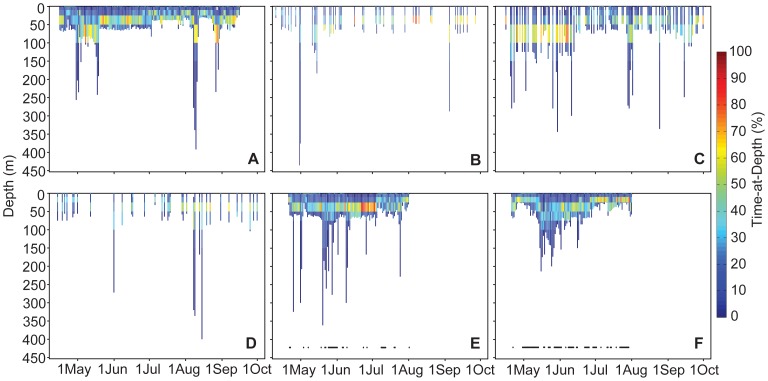
Percent daily time at depth.Daily time-at-depth (indicated by color across y-axis) by Manta alfredi for the duration of satellite tag deployment in 2011 near Al Lith, KSA. (A) Manta identification number MA106 (B) MA102 (C) MA105 (D) MA104 (E) MA112 (F) MA111. Black points at the bottom of panels (E) and (F) indicate days for which the satellite tags resolved FastLoc GPS locations.